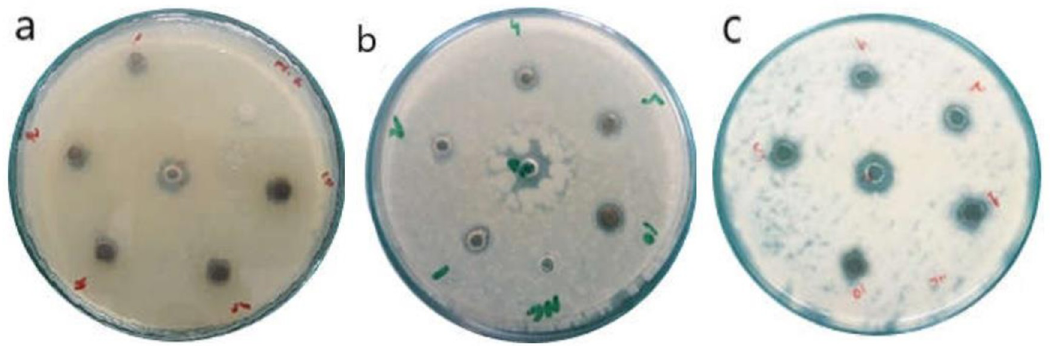
Fig 7. Representative images of antimicrobial activity of synthesized AgNPs against Staphylococcus epidermidis (a), Pseudomonas aeruginosa (b) and Fusarium solani